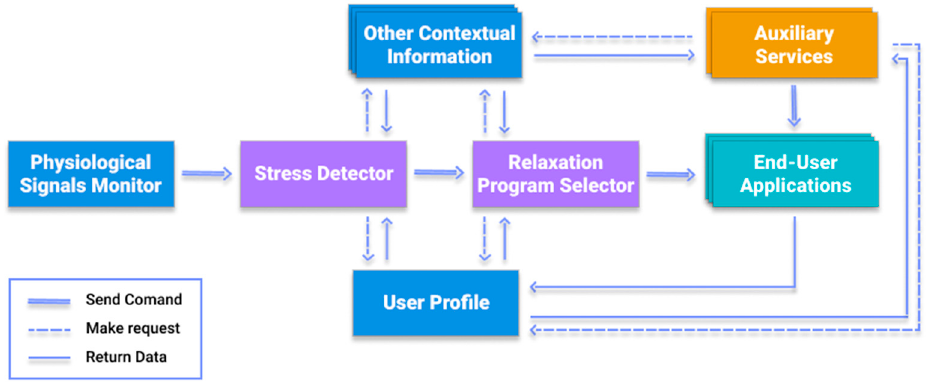
Figure 4. High level architecture of